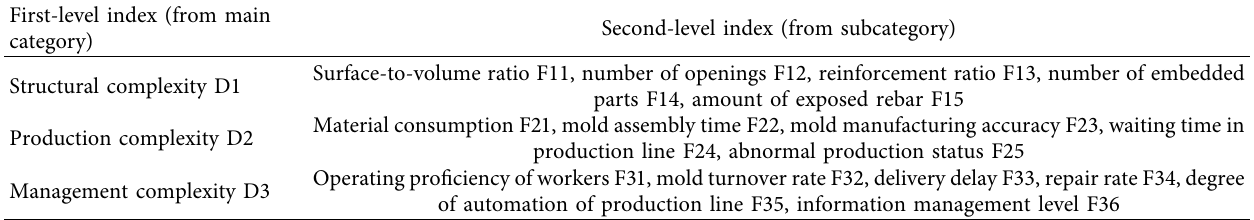
Table 5: Final complexity index system for PC